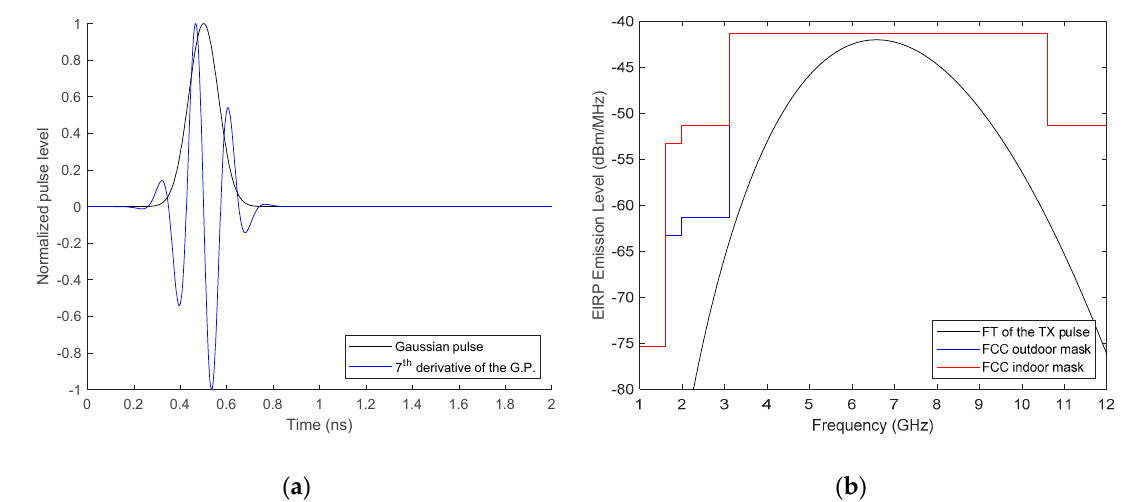
Figure 15. Response of the 7 th -derivative of the Gaussian pulse: ( a ) Time domain response and comparison with the Gaussian pulse; ( b ) Frequency response and FCC mask.